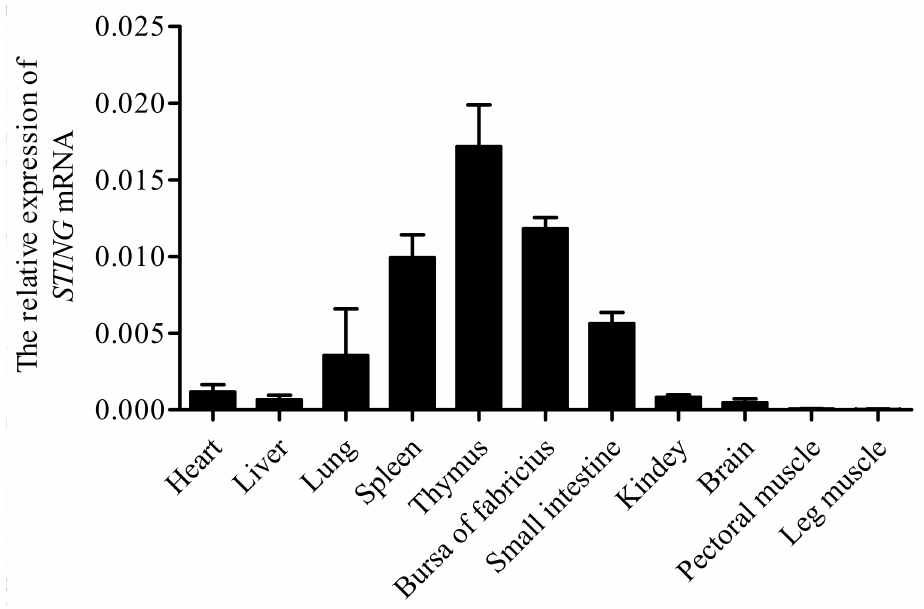
Figure 4. Relative expression levels of STING gene in different tissues of chicken were measured. Total RNA from different tissues of three chickens was used to perform the real-time PCR. The expression levels of chicken STING gene were normalized to the expression of GAPDH gene. The values represent the mean ± SD ( n =